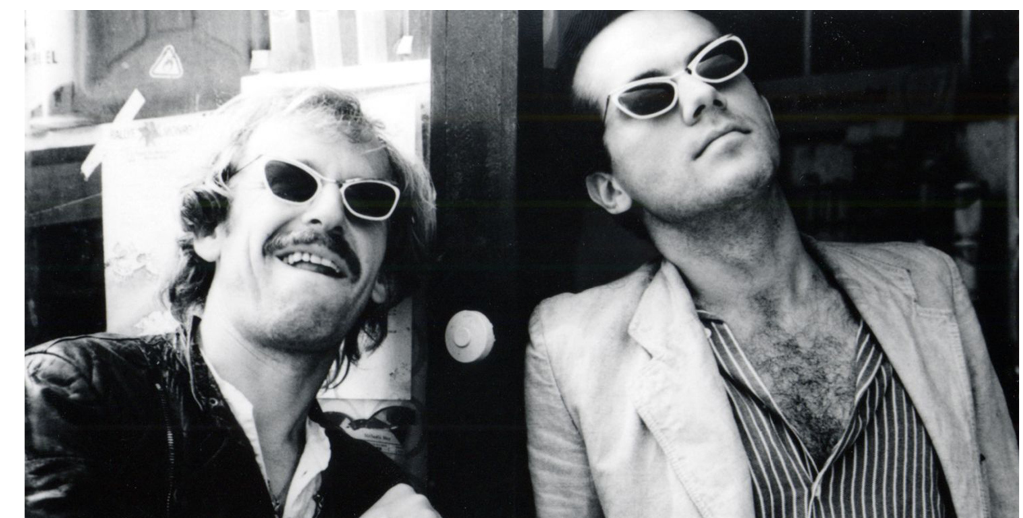
Figure 3a/b : Kings of the